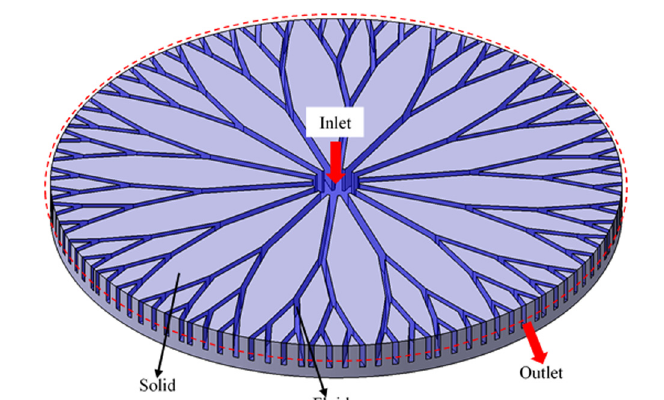
Table 2: Advanced structure, challenges, and limitations of passive methods in a microchannel Yan et al. [ 106 ] Design: Secondary fl ow and fl ow disruption